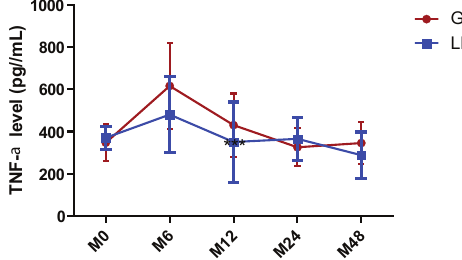
FIGURE 5 - Synovial fluid TNF level observed at 0, 6, 12, 24 and 48 hours after